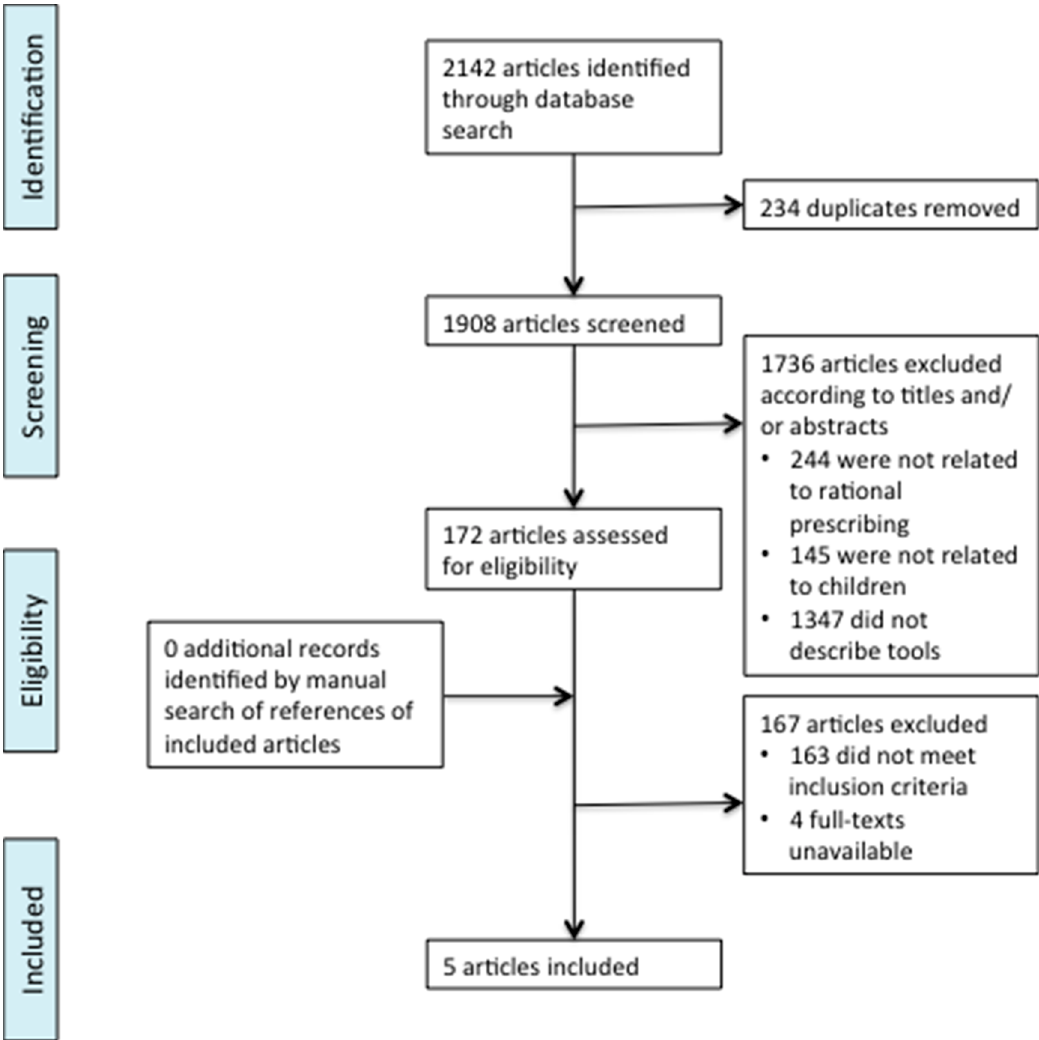
Figure 1. Flowchart of screening process for literature search. Adapted from the PRISMA group statement [8].